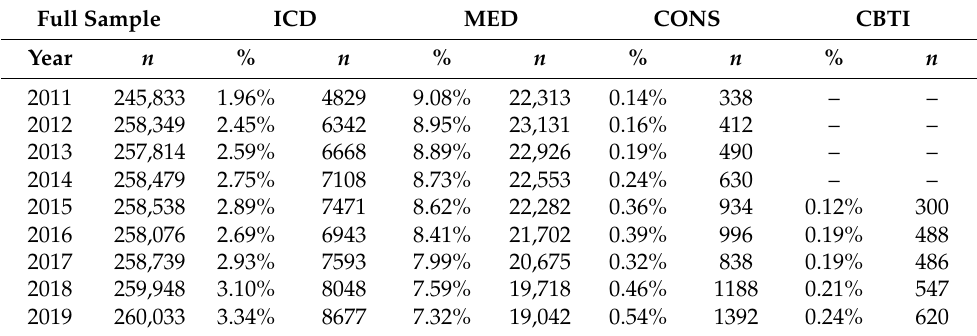
Table 1. Prevalence and count of insomnia indicators by year.